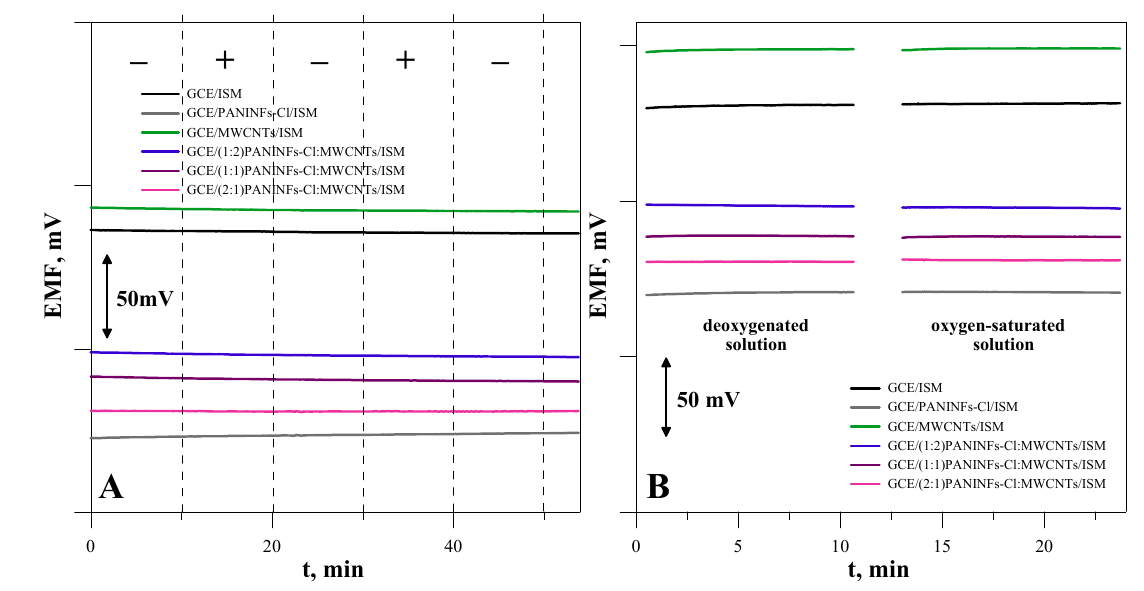
Figure 10. The effect of ( A ) light, ( B ) O 2 on the electrode potential.